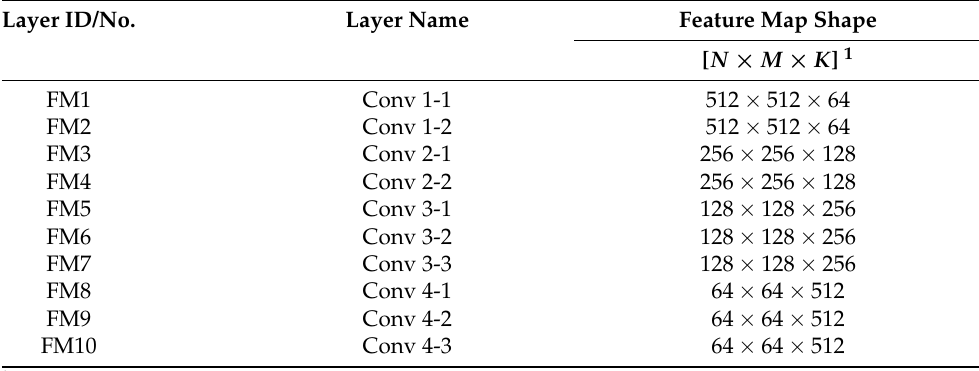
Table 1. Summary of the CNN’s first 10 feature maps that were investigated for suitability to provide useful information for prediction of image quality. The number of channels of the feature map determines the dimensionality of the sampled feature vector. Layer